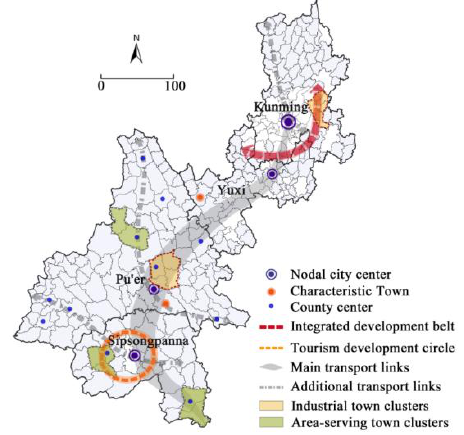
Figure 6. The spatial pattern of regional small towns.